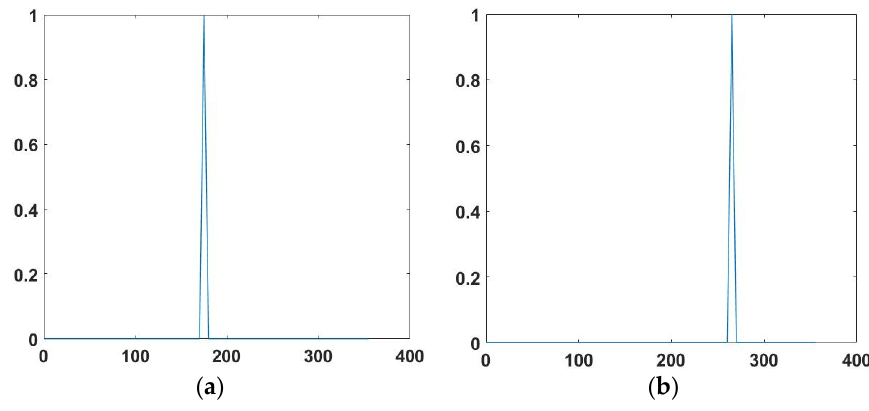
Figure 20. The azimuth estimation results, ( a ) DOA = 180°; ( b ) DOA = 270°.